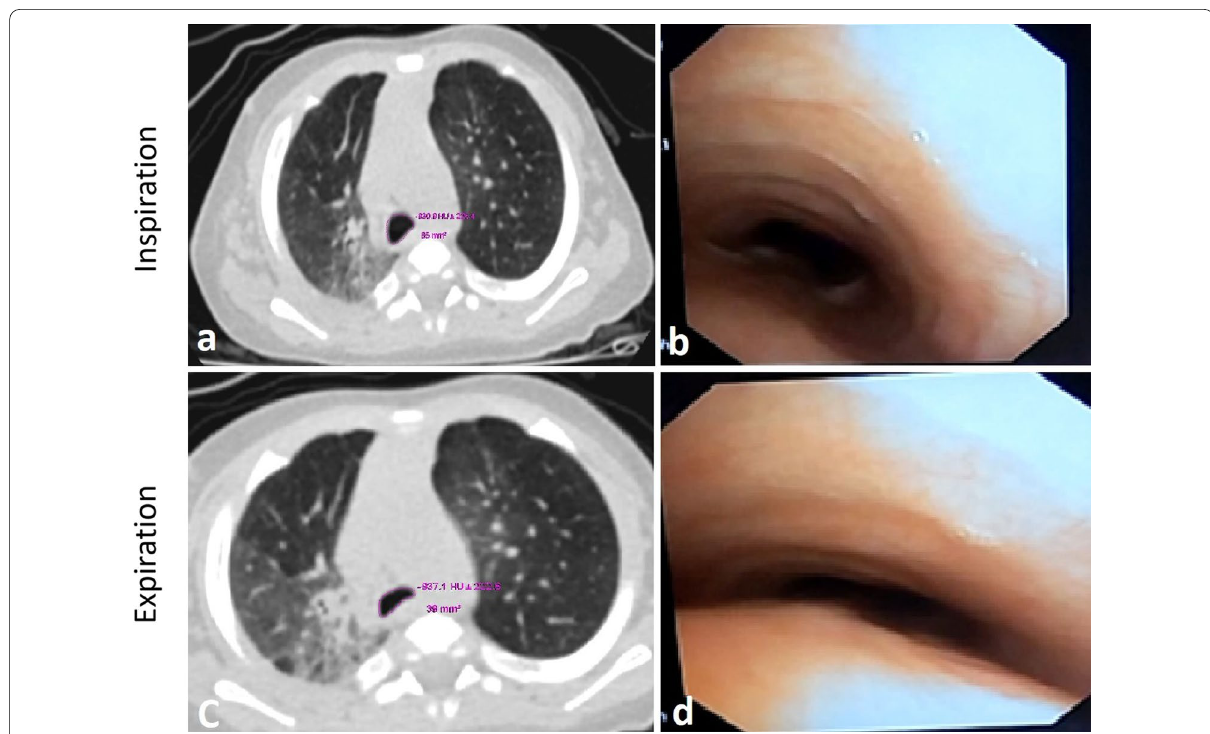
Fig. 4 Expiratory central airway collapse with mildly discordant result of cross-sectional area reduction between CT and bronchoscopy. Cross-sectional area measurement of trachea at aortic arch level using cine CT during end-inspiratory ( a ) and end-expiratory phases ( c ) revealed significant expiratory airway collapse that was calculated to be 50% cross-sectional area reduction at CT. Corresponding flexible bronchoscopy images ( b , d ) confirms the presence of expiratory central airway collapse but with slightly higher degree than that perceived with CT. However, both results are still within the same severity score (class 2; 50–70% cross-sectional area reduction) ≥